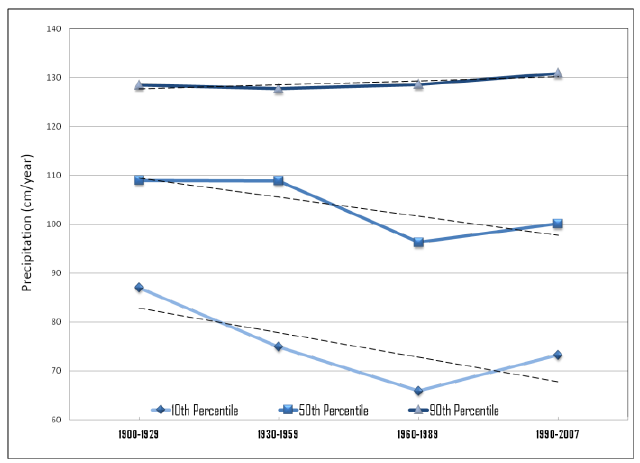
Figure 21. Annual precipitation quantiles for dry forest by period.